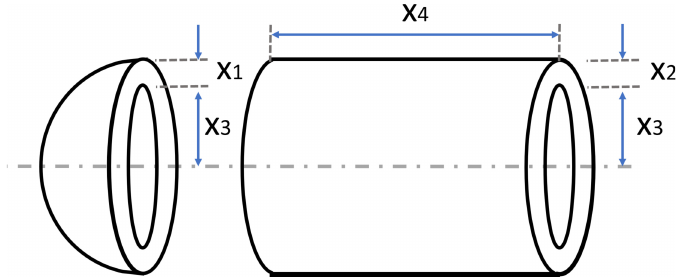
Figure 7. Schematic view of the cylindrical pressure vessel design problem.